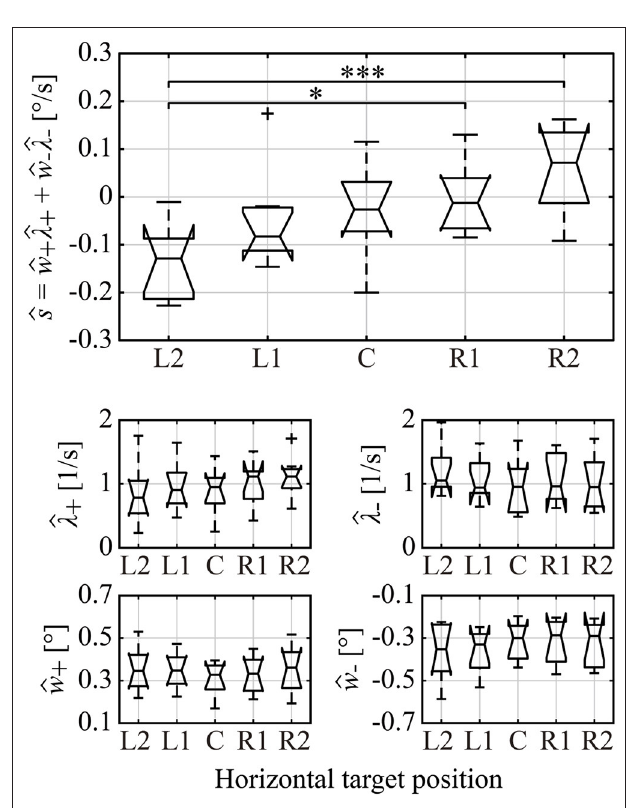
FIGURE 8 | Boxplots of the estimated amplitude and occurrence frequency of right/left MS, and the total trend generated by total MS across all subjects. ˆ w + , ˆ w − , ˆ λ + , and ˆ λ − represent the subject-wise mean values of the right/left MS amplitude and occurrence frequency, respectively. ˆ s , ˆ w + ˆ λ + + ˆ w − ˆ λ − is the estimated total trend of MS reconstructed from ˆ w + , ˆ w − , ˆ λ + , and ˆ λ − . Single and triple asterisks indicate a significant difference between the groups at the 5 and 0.1% significance level,